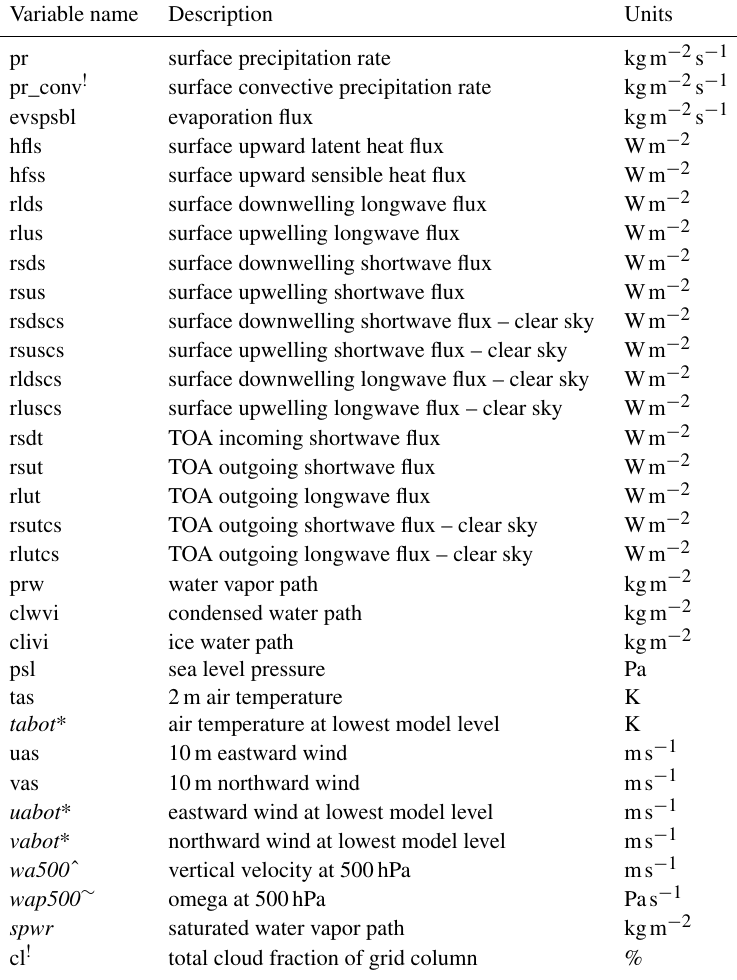
Table 5. The 2-D hourly-averaged variables ( x,y,t